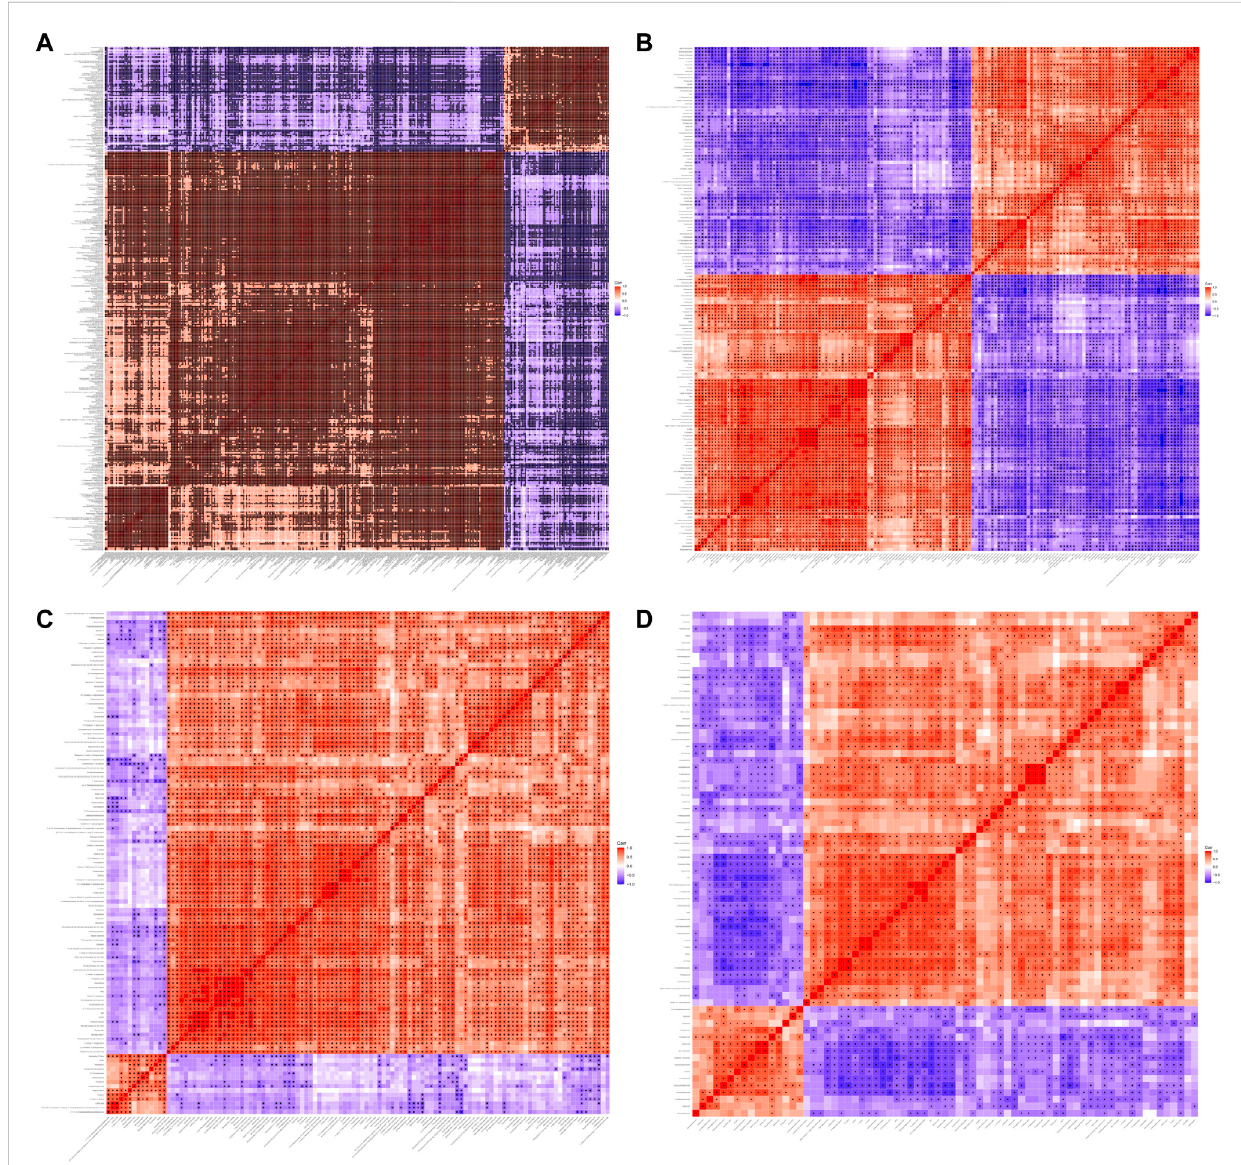
FIGURE 6 Heatmap of correlation analysis between three groups. Heatmap of correlation analysis N versus M in positive (A) and negative (B) ion mode. Heatmap of correlation analysis M versus AMCZ in positive (C) and negative (D) ion mode.